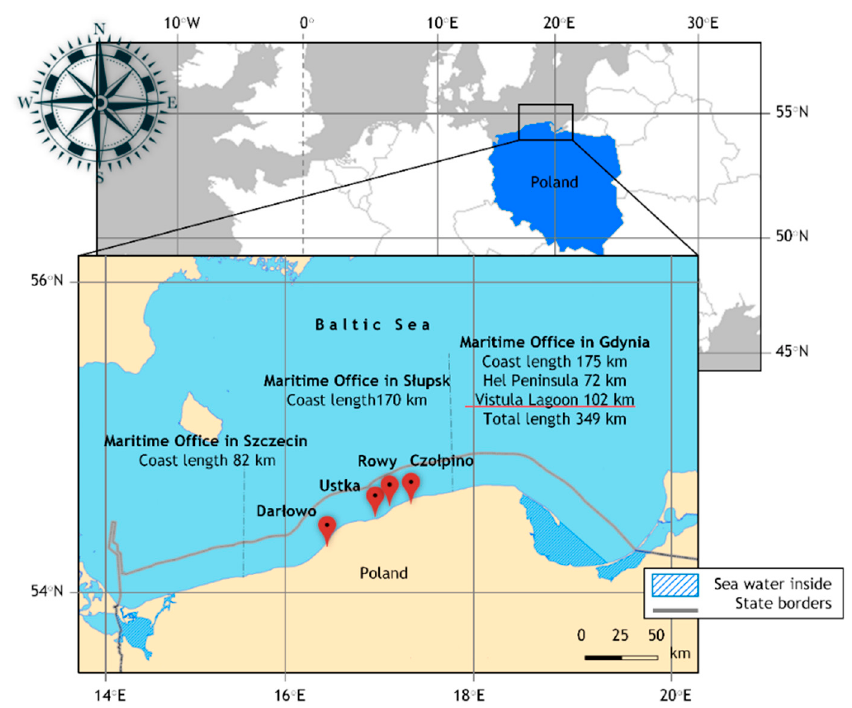
Figure 1. Localization of the four natural beaches studied in this field campaign in the central Pomeranian region, along the Polish part of the southern Baltic Sea coast.